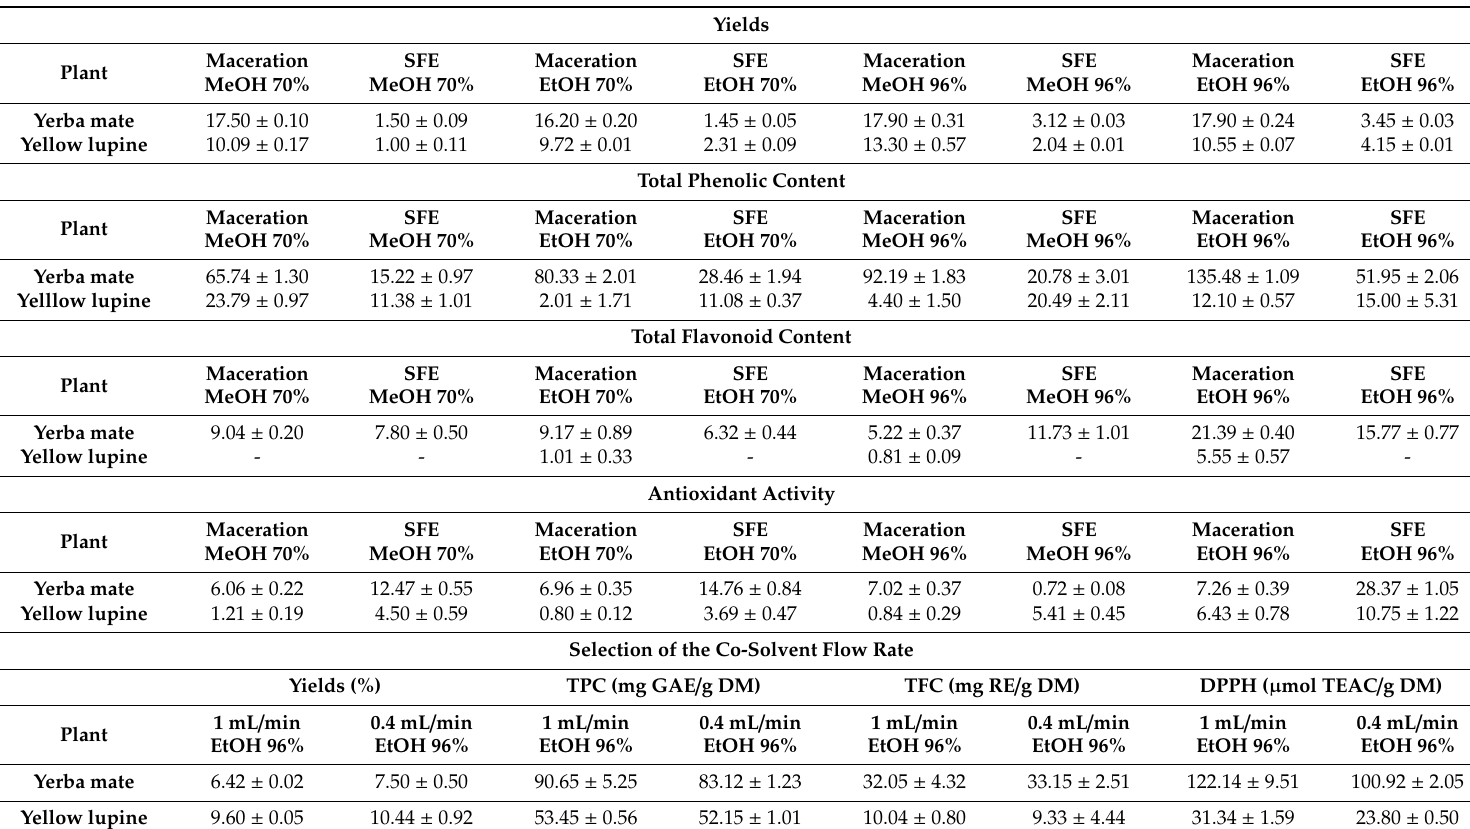
Table 1. Selection of the extraction method and solvent. Yields (%), total phenolic content (mg GAE / g DM), total flavonoid content (mg RE / g DM) and antioxidant activity obtained by the DPPH method ( µ mol TEAC / g DM) of the extracts obtained by di ff erent extraction methods and type of solvent as well as of the extracts obtained by SFE with di ff erent flow rate of co-solvent (96% EtOH) for di ff erent plants (T—50 ◦ C, p—300 bar, time—120 min, flow rate CO 2 —4 mL /